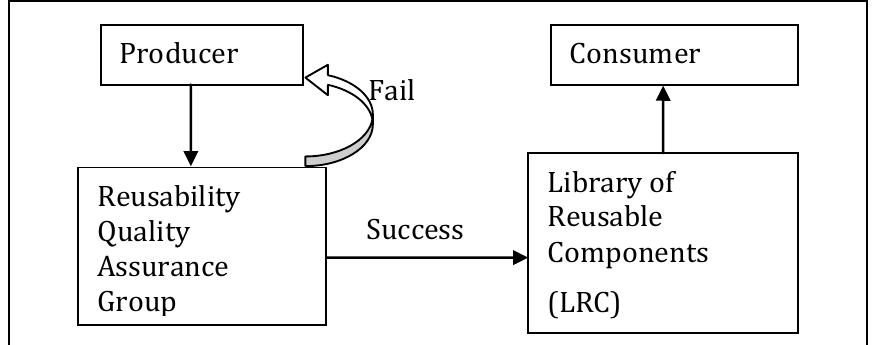
Figure III. The main elements of school’s reusable